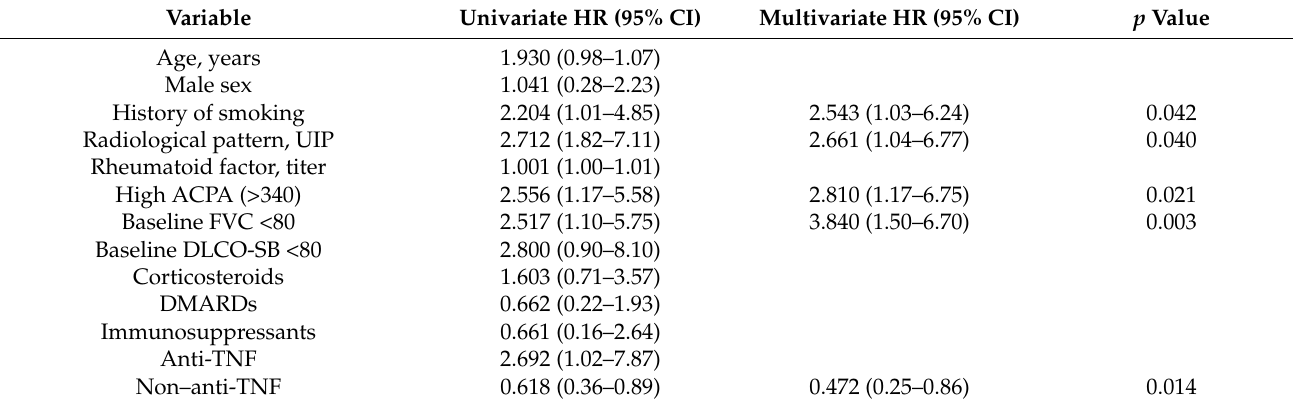
Table 5. Multivariate analysis of progression and mortality of lung disease in patients with RA-ILD taking DMARDs. Variable